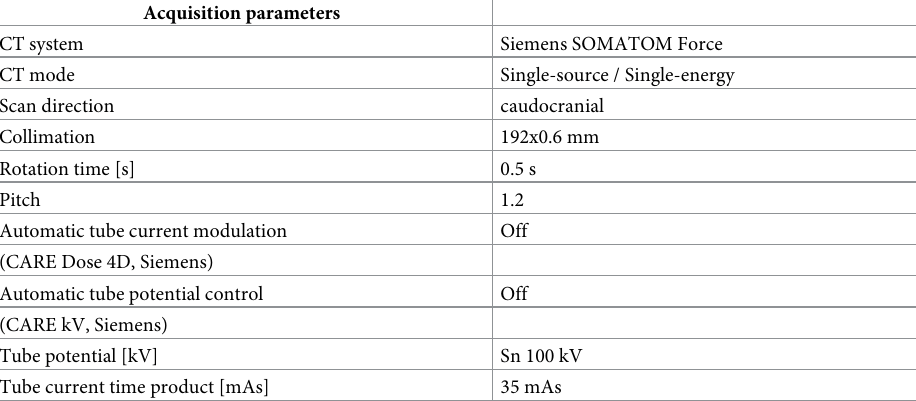
Table 1. Tin-filtered CT